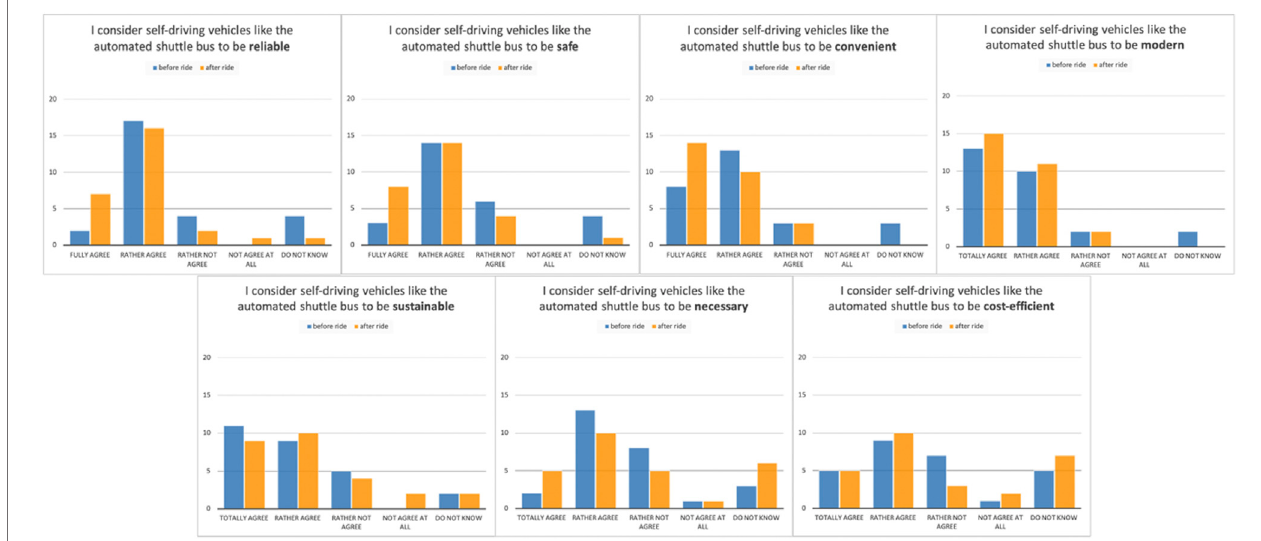
FIGURE 13 | Study 3: participants ’ assessments before and after using the shuttle.